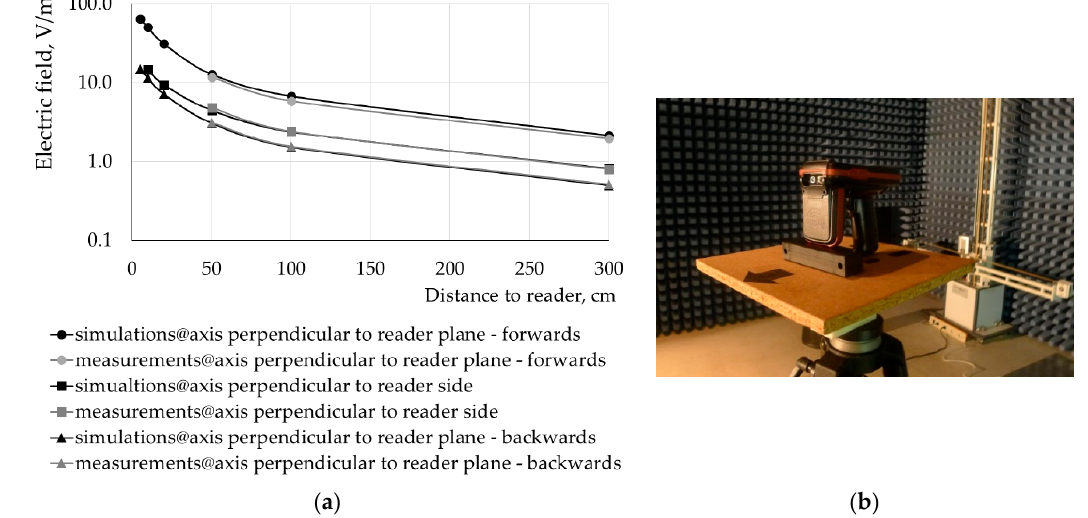
Figure 5. Electric field distribution near the UHF RFID gun reader normalized to a power of 1 W in the front or back of (along an axis perpendicular to the reader plane) and at the side of (perpendicular to the reader’s edge) the reader evaluated by measurements inside the semi-anechoic chamber and by numerical simulations ( a ) and the facilities used while the performing measurements inside the semi-anechoic chamber ( b ).